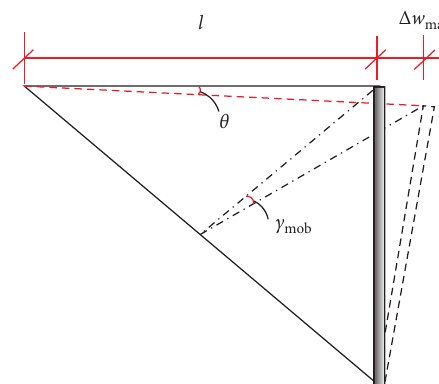
Figure 6: Deformation increment mechanism of cantilever foundation